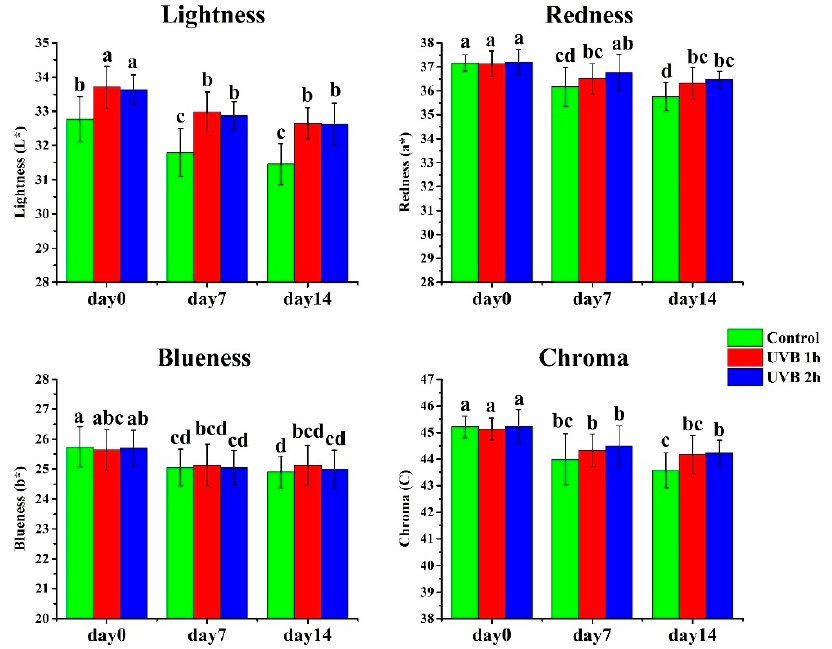
Figure 2. Effects of UV-B treatment on surface color of strawberry fruits. The data are based on ten biological replicates. * p < 0.05.